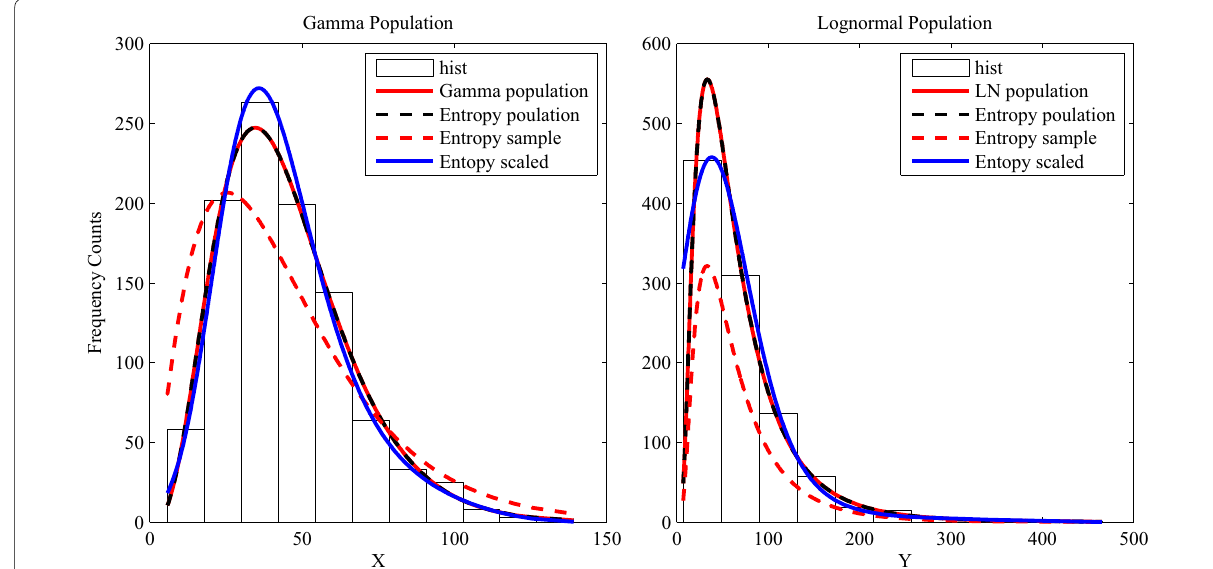
Fig. 1 Comparison of the true population and POME-based distributions from given population or from first four moments about origin (i.e., entropy scaled)